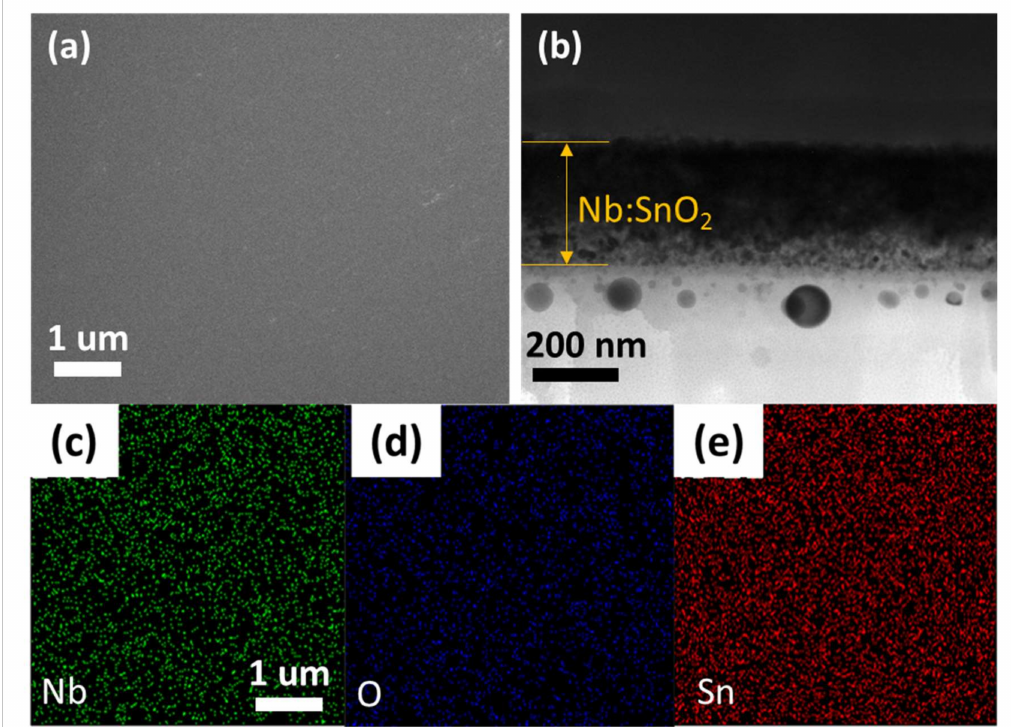
Figure 2. FESEM ( a ) surface image and ( b ) cross-section image of the as-deposited Nb-doped SnO 2 thin film. The elemental mapping of ( c ) Nb, ( d ) O, and ( e ) Sn. Nb:SnO 2 thin films deposited at 4.0 sccm of oxygen flow